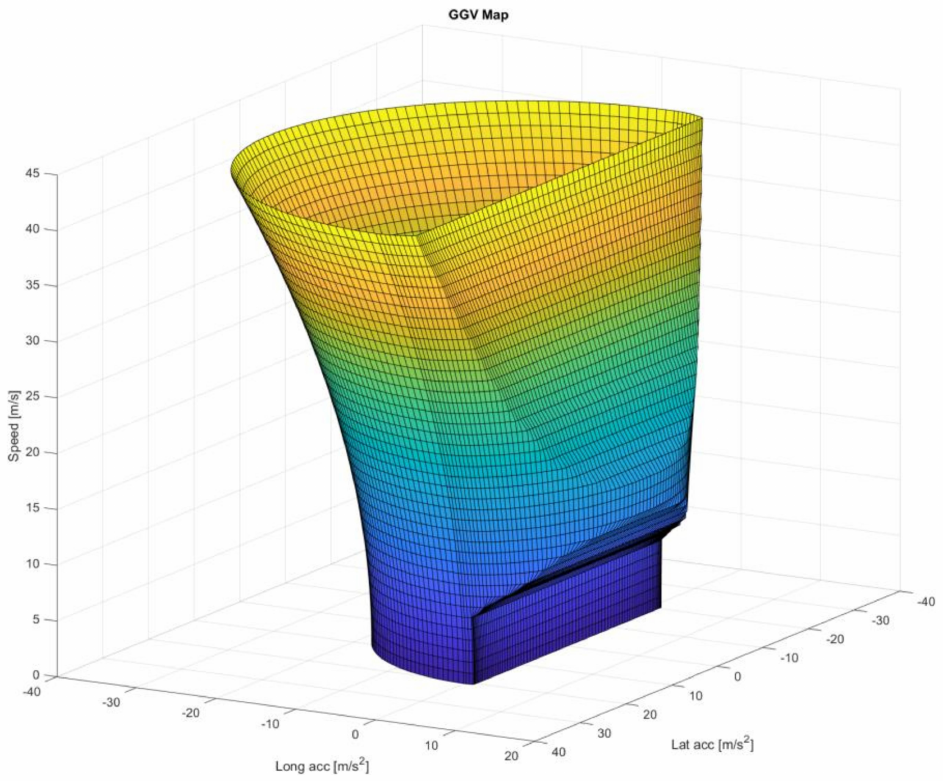
Figure 4. Performance envelope of the BS19 Formula Student